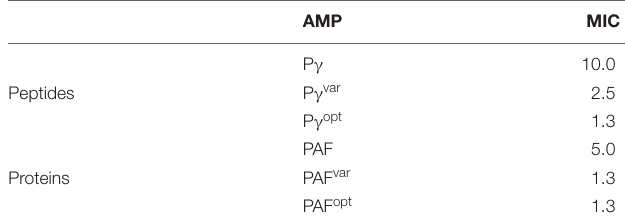
TABLE 1 | MICs of PAF peptide and protein